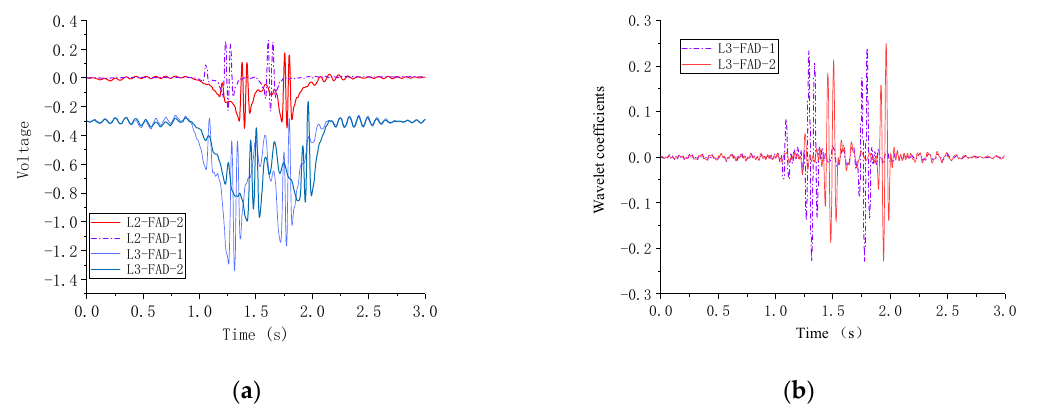
Figure 17. Case study of multiple presence loading event: ( a ) raw signals; ( b ) optimal wavelet coefficients.